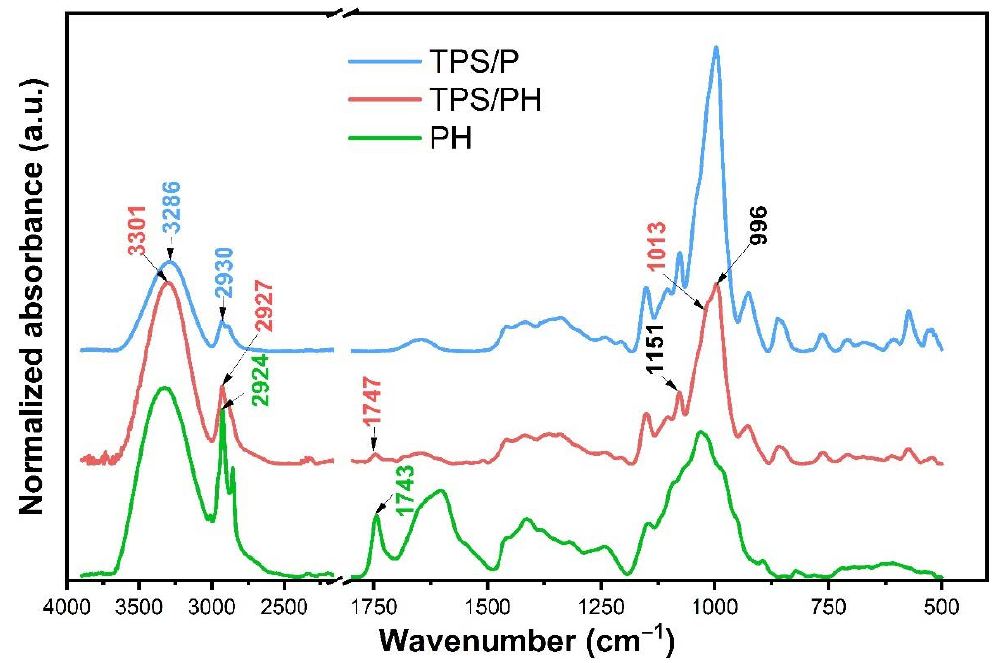
Figure 4. Average FTIR spectra of psyllium husk (PH), native TPS/P, and chemically modified starch composite TPS/PH films. The band positions in black indicate the same values for TPS/P and TPS/PH samples.